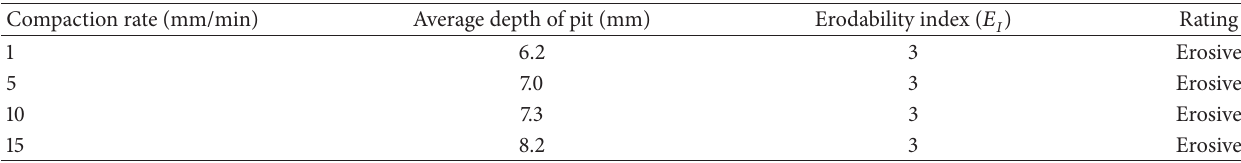
Table 4: Drip test results.